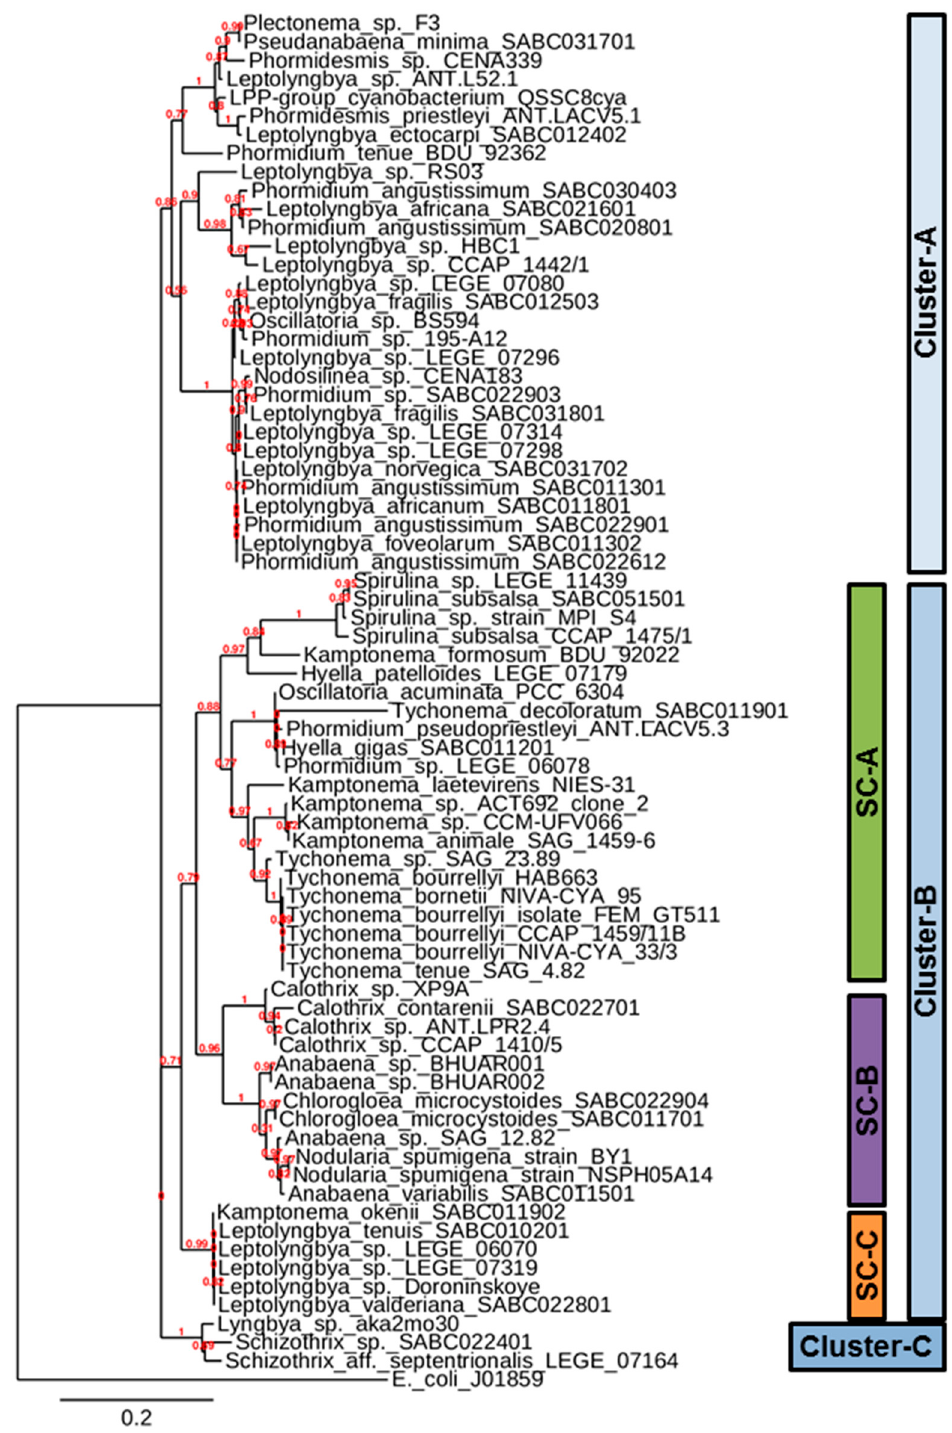
Figure 3. Phylogenetic tree of twenty-five cyanobacterial strains from the Shannon ABC biobank along with Genbank selected cyanobacteria based on their 16S rRNA sequences, outrooted with 16S rRNA sequence of E. coli (J01859). SC-A, sub-cluster-A; SC-B, sub-cluster-B and SC-C, sub-cluster-C.